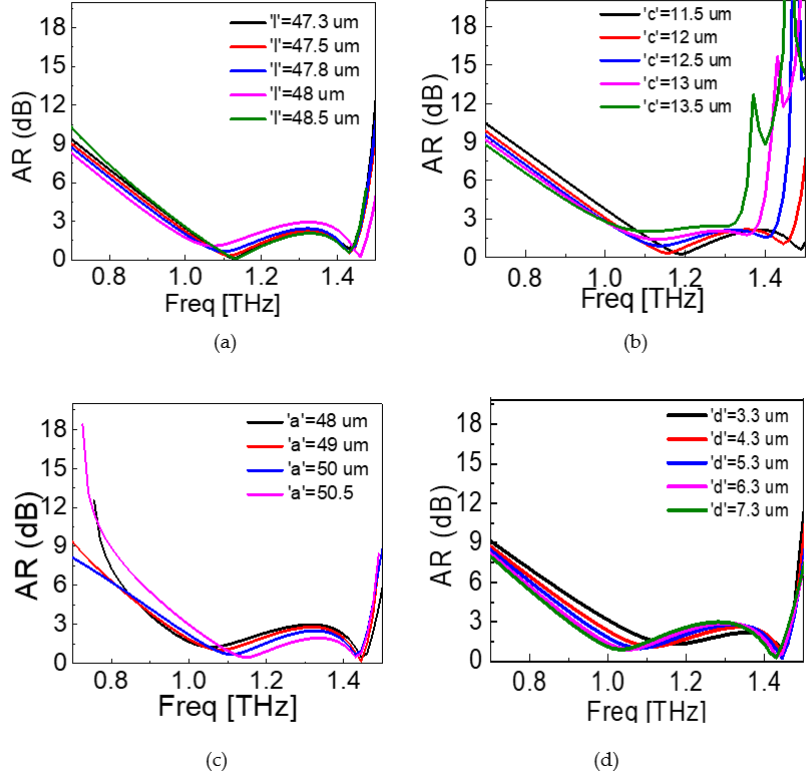
Figure 10. Effect of ( a ) ‘l’, ( b ) ‘c’, ( c ) ‘a’, and ( d ) ‘d’ on the performance of the LCPC. Figure 10. E ff ect of ( a ) ‘ l ’, ( b ) ‘ c ’, ( c ) ‘ a ’, and ( d ) ‘ d ’ on the performance of the